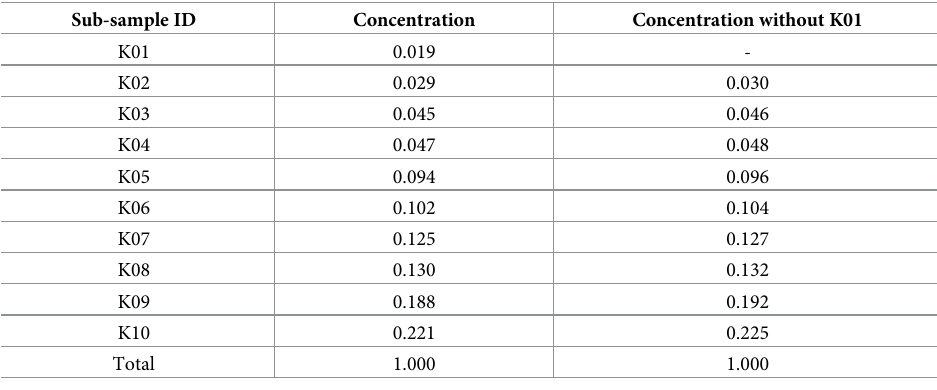
Table 2. Concentration of kangaroo